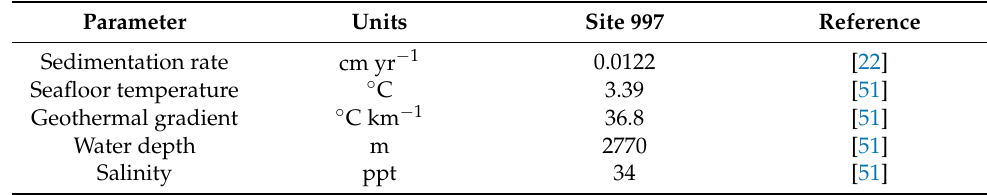
Table 1. Parameters used in the model.